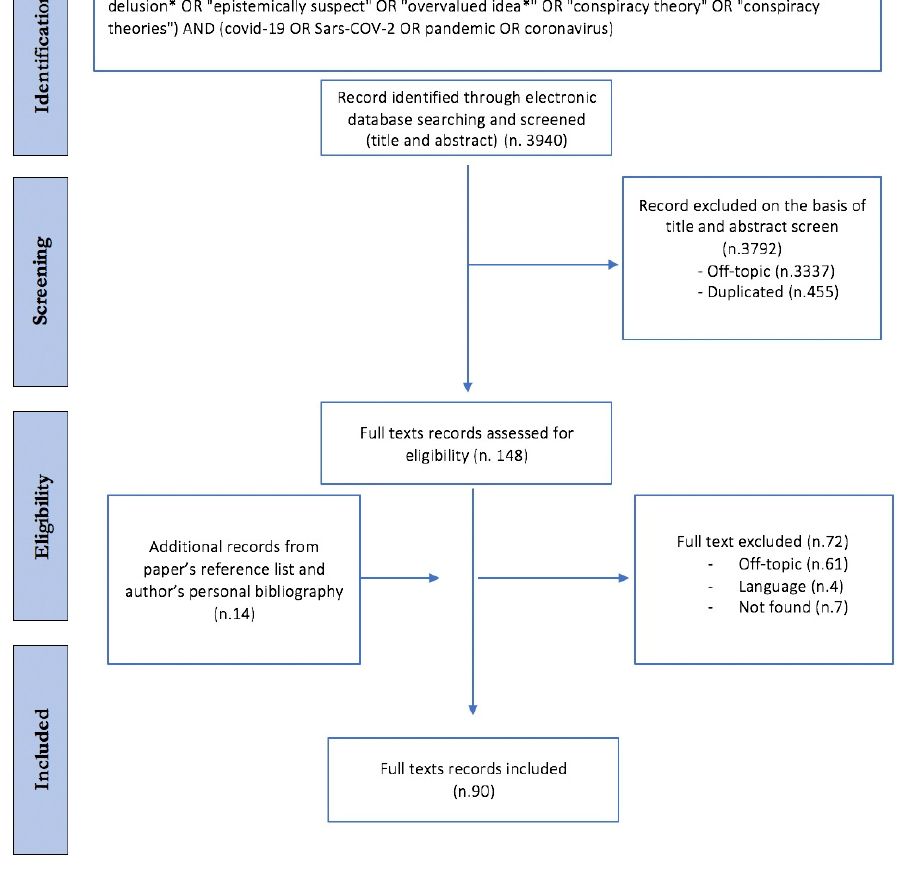
Figure 1. Prisma 2009 flow diagram: selection of included studies. Abbreviations: COVID-19 (coronavirus disease 2019); Sars-COV-2 (severe acute respiratory syndrome coronavirus 2).